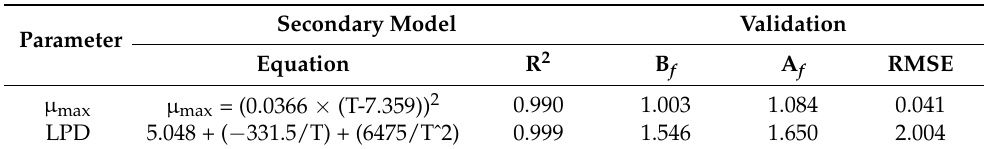
Table 1. Kinetic parameters as calculated by the Baranyi model for the growth of Salmonella spp. in Table 2. Secondary model of the growth of Salmonella spp. in LEW and validation of the devel- LEW during storage at 10, 15, 25, and 37 °C. oped model.